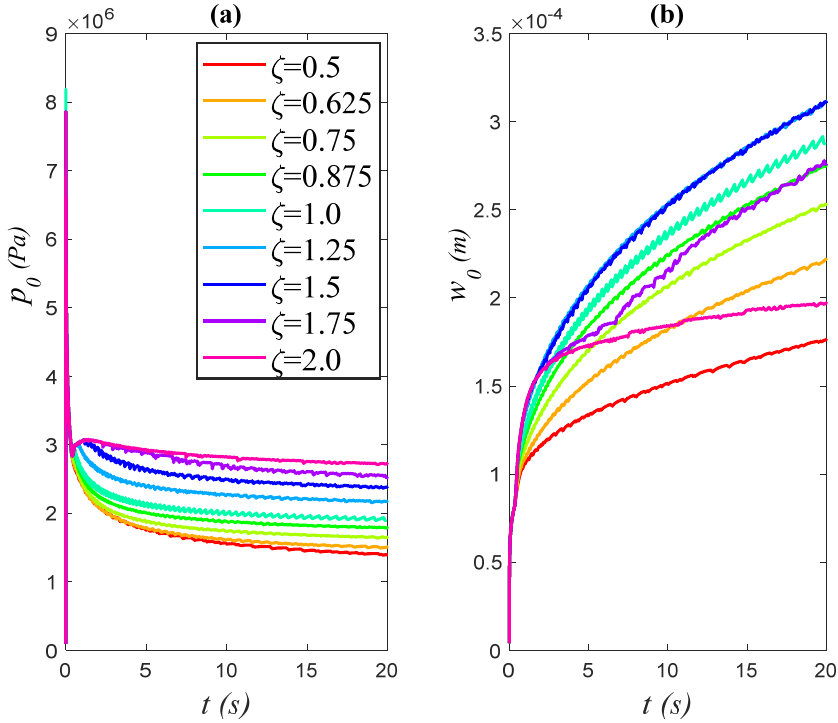
Figure 24. Evolution of the fluid pressure p 0 and the fracture opening w 0 at the wellbore under the proportion of pay zone 𝜉 = 5 9⁄ .